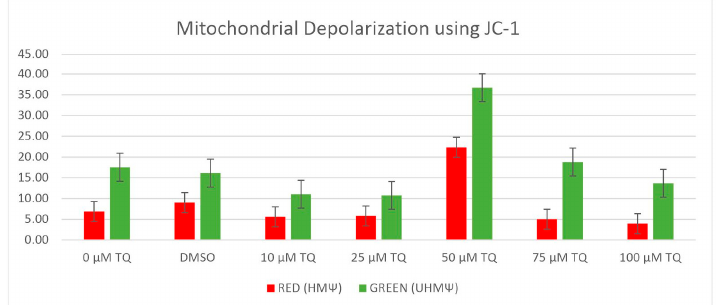
Figure 9. The upper panel shows the rationale of using JC-1 to determine the depolarization/disruption of the mitochondrial membrane, with the three-color histograms of red, green, and blue fluorescence representing 0 TQ, DMSO, and 50 µM TQ for HepG2 cells, and the mitochondrial depolarization for HepG2 using JC-1. A decrease in the red (~590 nm)/green (~529 nm) fluorescence intensity ratio after exposure to TQ is indicative of depolarization/disruption of the mitochondrial membrane. Three independent experiments were carried out for each concentration. The variation in the mitochondrial depolarization is significant ( p < 0.001, two-tailed test). Red means healthy mitochondria (HM Ψ ) while green means unhealthy mitochondria (UHM Ψ ) (RGB, red, green, and blue fluorescence channels; for each fluorescence channel evaluation, there is mean, the standard deviation, and the